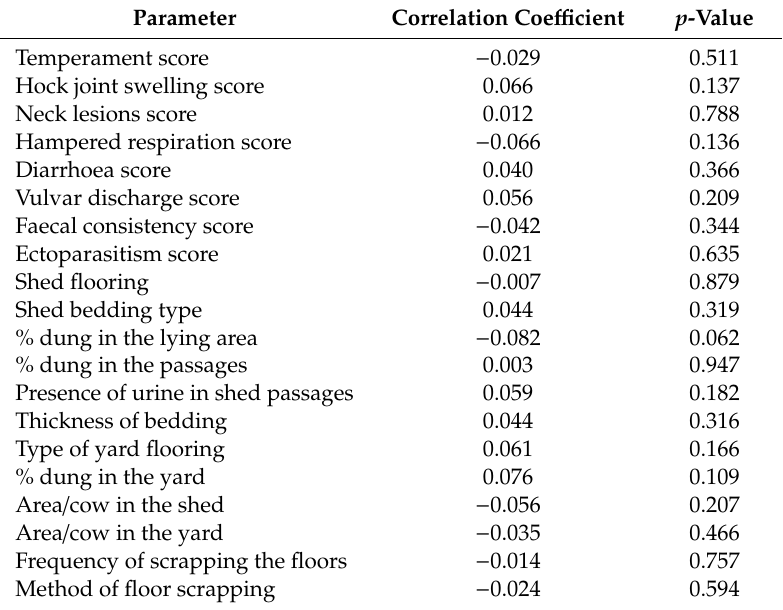
Table 5. Spearman’s Rank Correlation coe ffi cients with p -values for hair cortisol concentration (pg / mg) with animal-based and resource-based parameters which were not significant ( p >